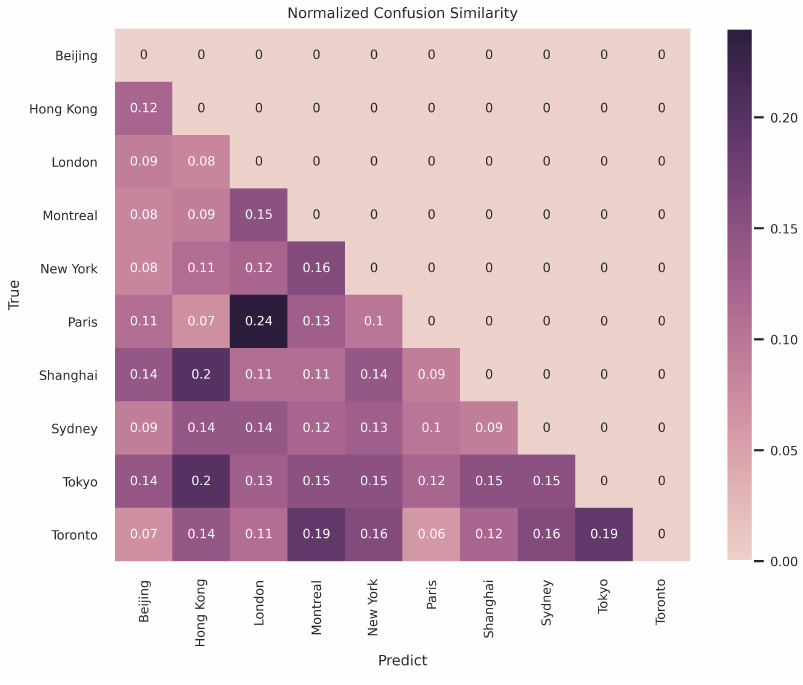
Figure 5. Normalized landscape similarity